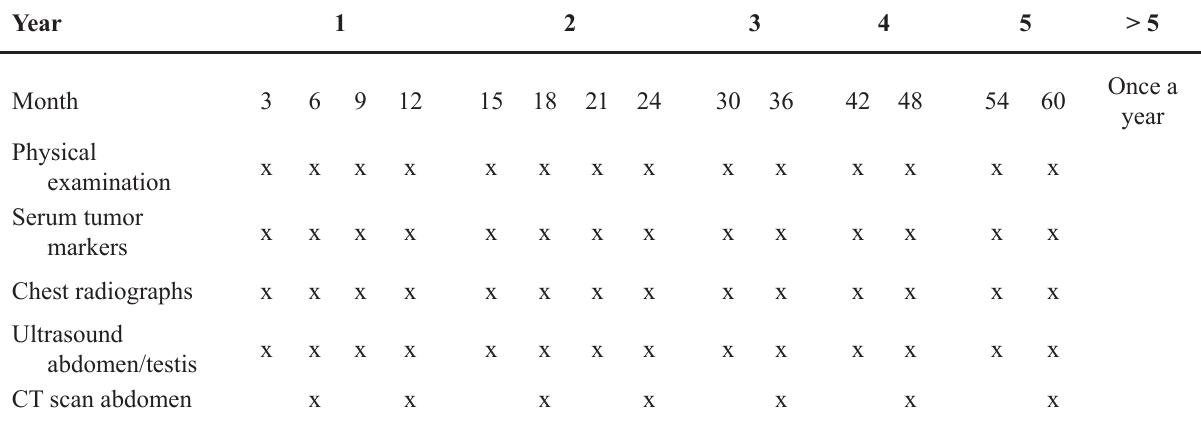
Table 1 – Follow-up evaluations.